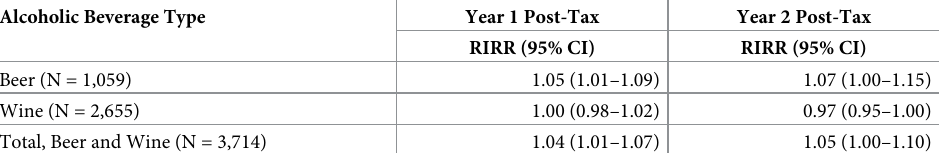
Abbreviations: RIRR, ratio of incidence rate ratios.